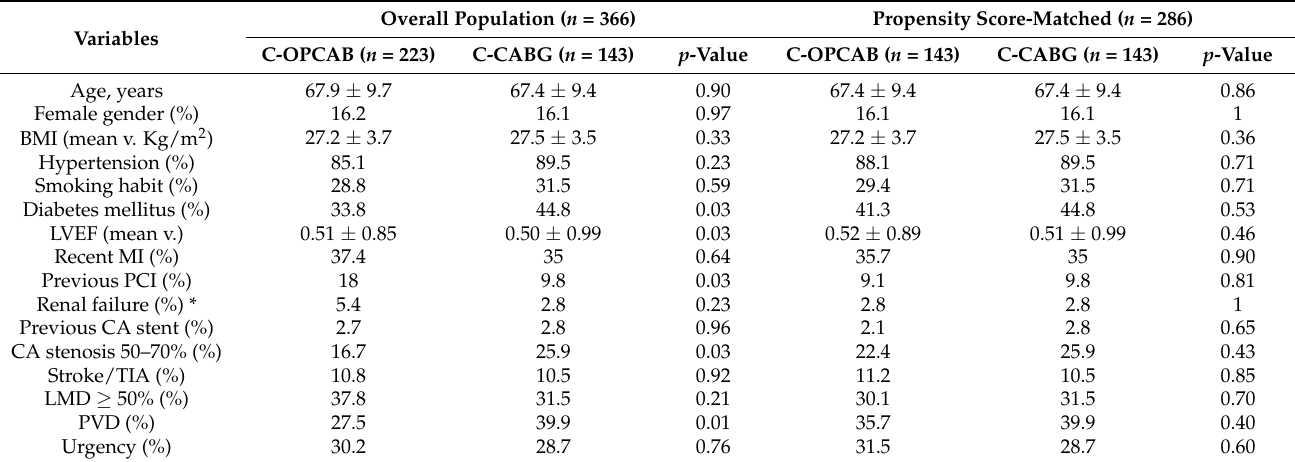
Table 1. Patients requiring coronary surgery reoperation or concomitant procedures, i.e., valve surgery, replacement of ascending aorta, and ventricular resection, were excluded from the study. Table 1. Patient population’s characteristics before and after